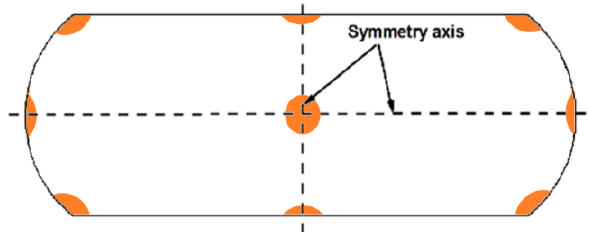
Figure 2. The longitudinal section of a cylindrical specimen after compression. The zones of the EBSD analysis of the specimen microstructure are highlighted in orange.